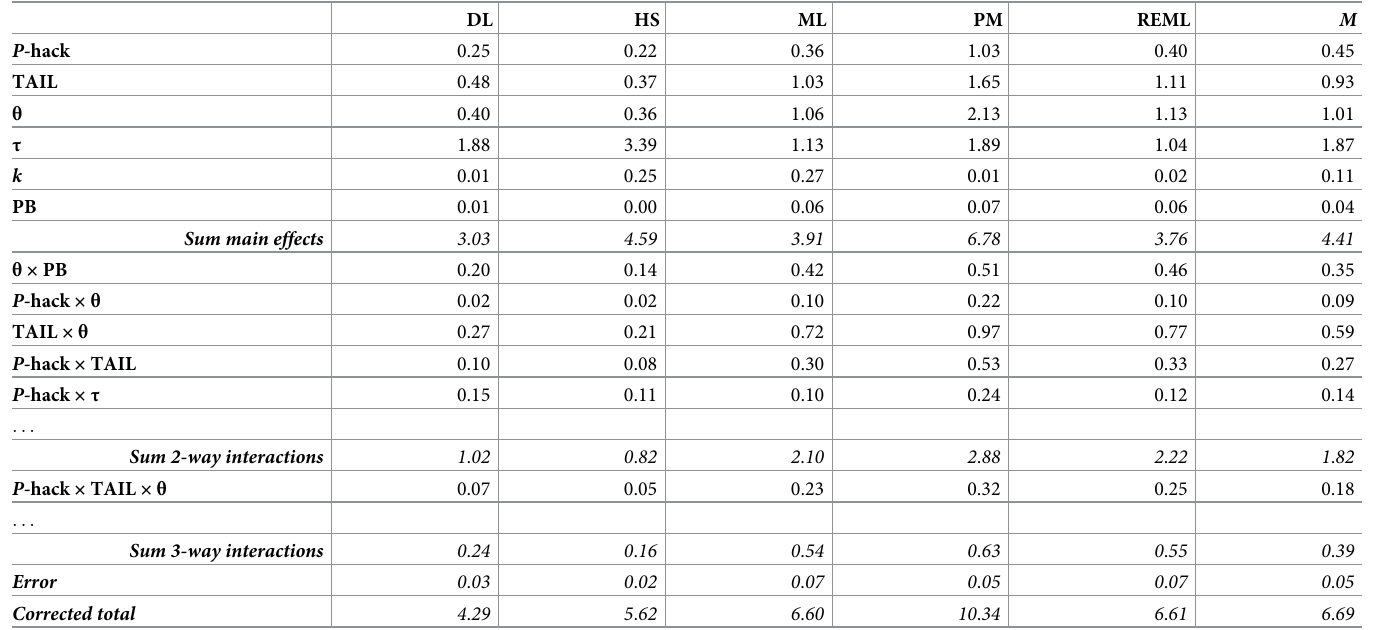
Table 2. The relative importance of design factors for T bias . Selected sum of squares from six-factorial ANOVA for five heterogeneity estimators.